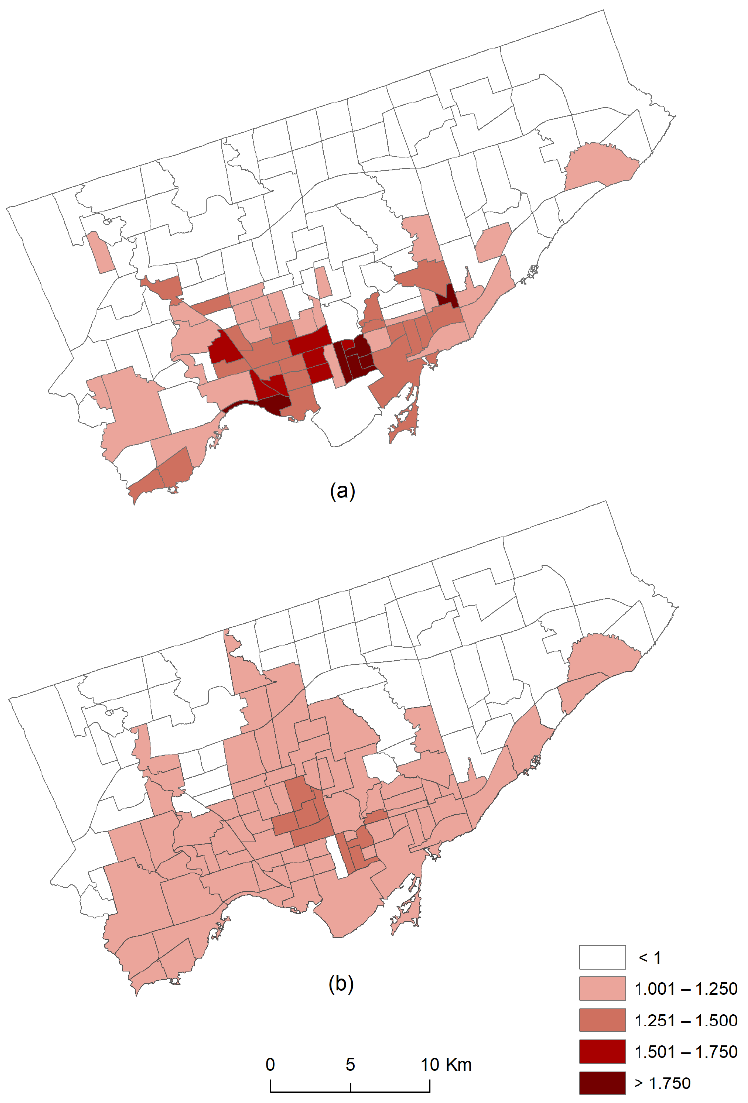
Figure 6. The posterior mean of the relative risk ( r ik ) of ( a ) psychotic and ( b ) non-psychotic disor- ders.